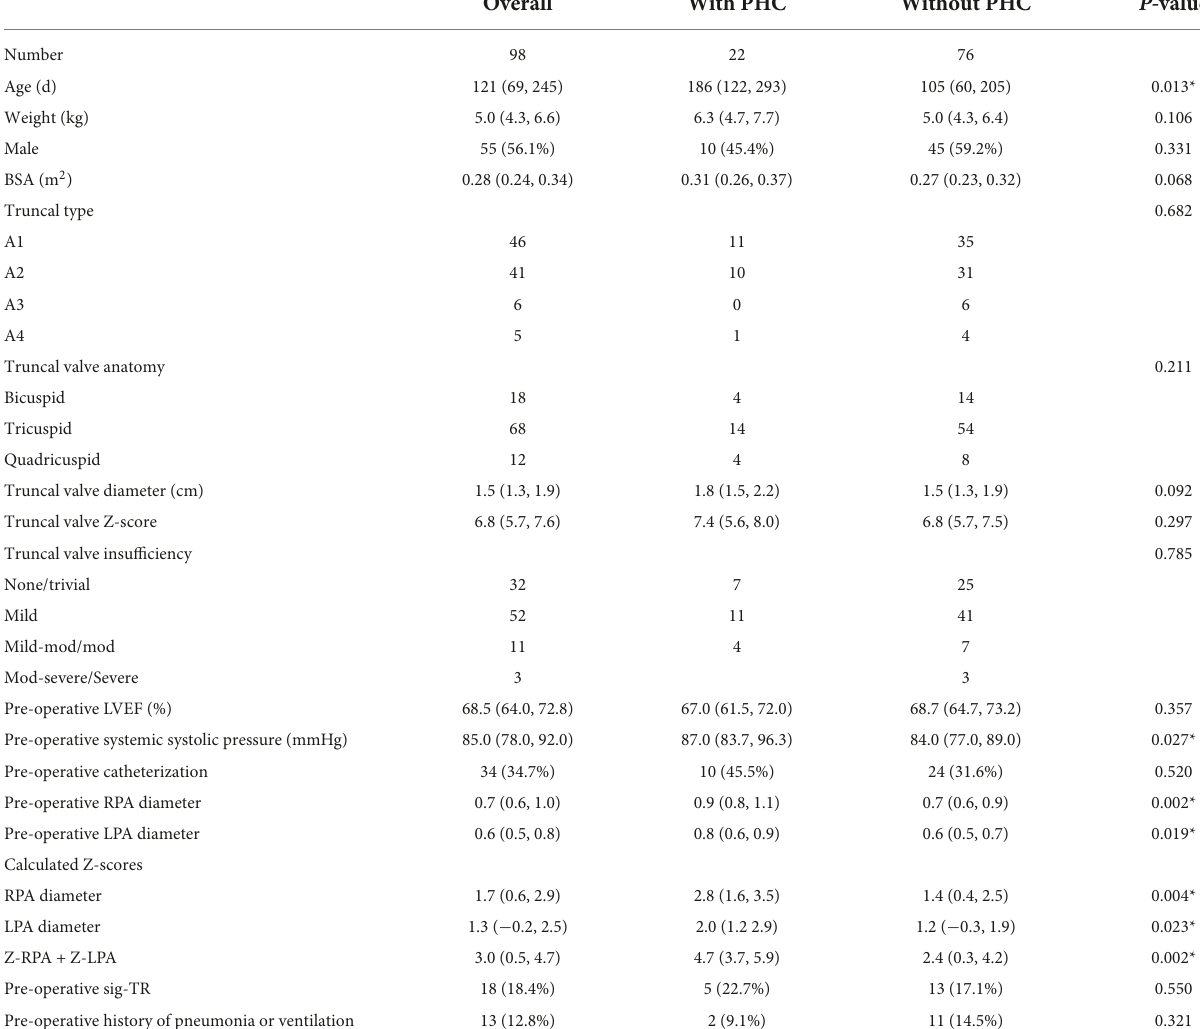
TABLE 1 Patients’ characteristics before surgical repair of truncus